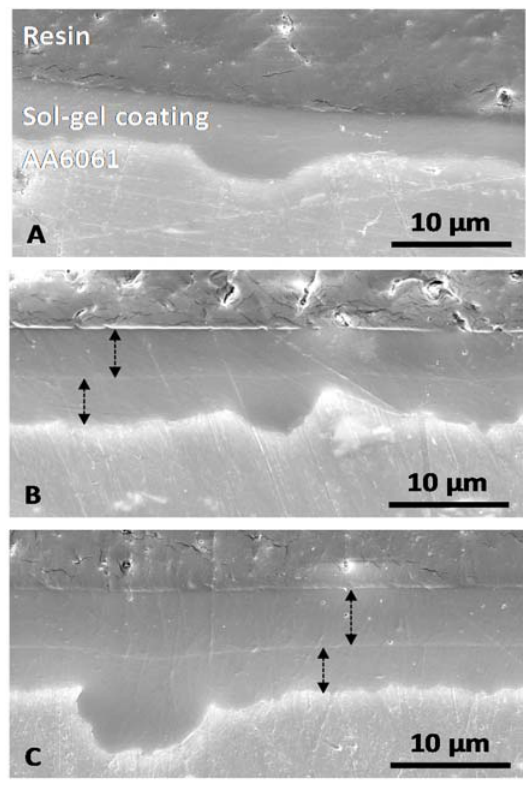
Figure 10. Scanning electron micrographs of cross-section for bilayer systems versus withdrawal speeds: ( A ) 200; ( B ) 400 and ( C ) 600 mm min − 1 .